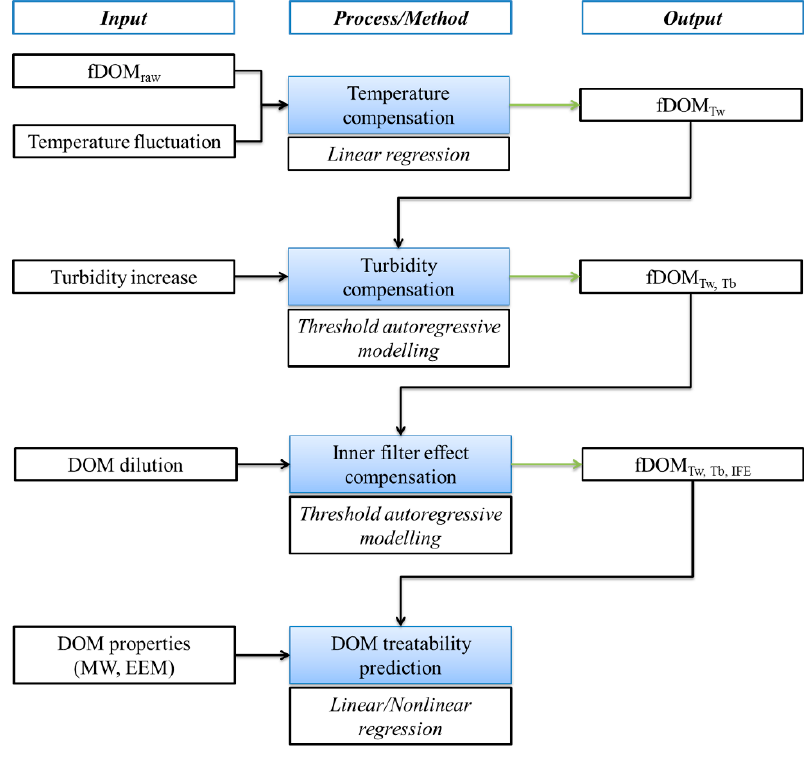
Figure 1. Sequential fluorescent dissolved organic matter (fDOM) compensation method.